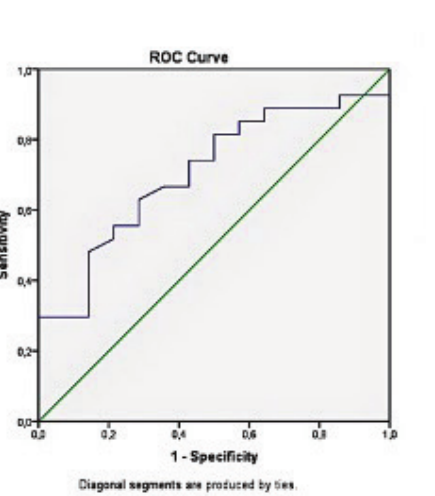
Figure 2 - ROX index ROC curve